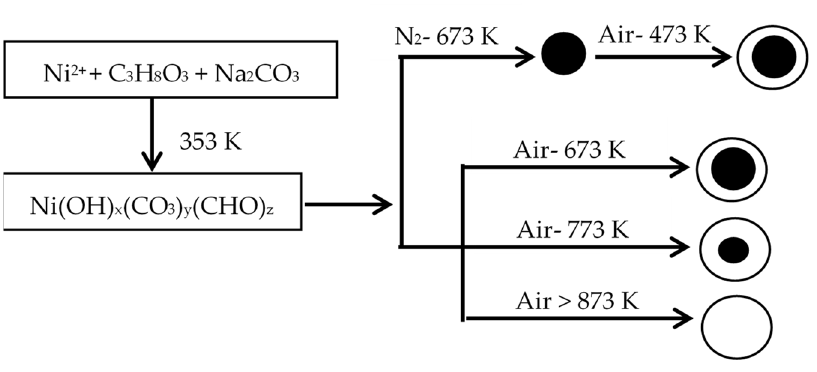
Figure 7. Synthetic procedures for Ni and Ni / NiO nanoparticles. Reproduced with permission from [33], published by Elsevier B.V., 2017.